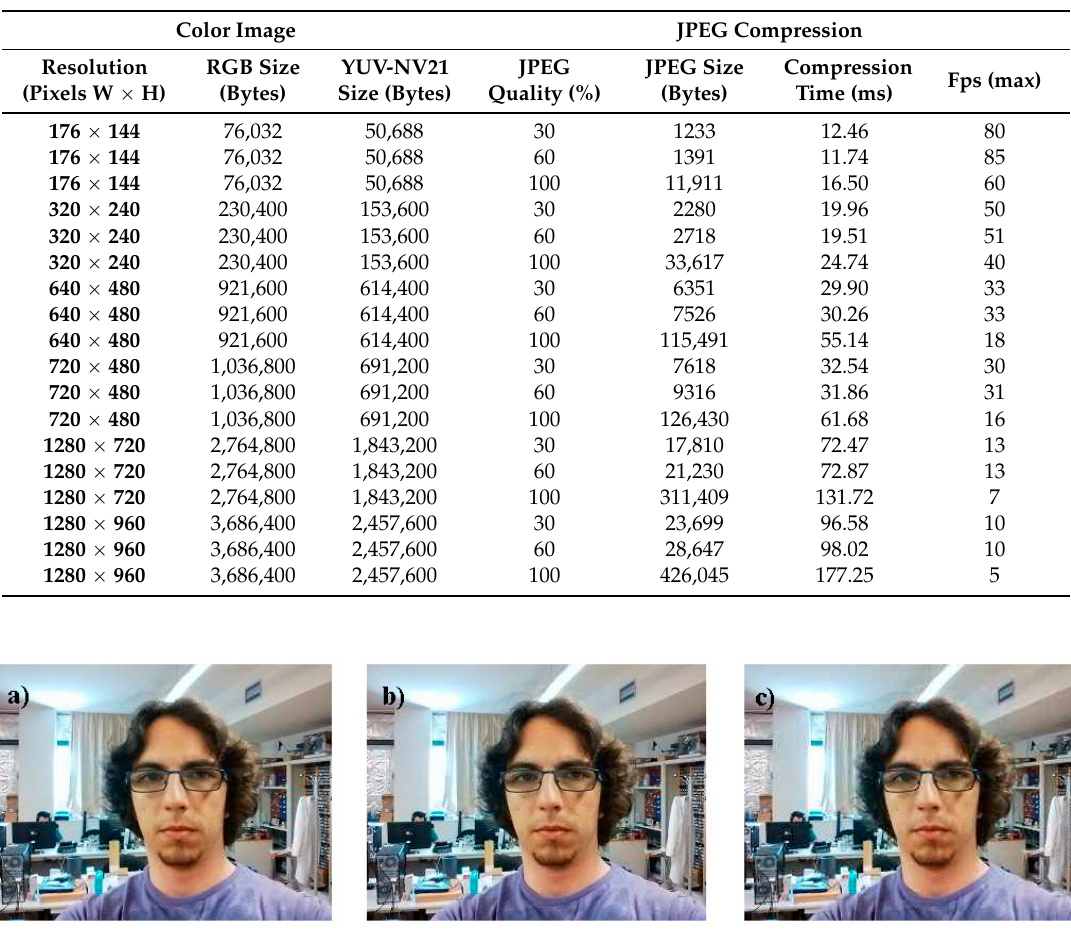
Figure 9. Sample 320 × 240 color image showing the small differences obtained after a JPEG compression and decompression procedure with quality settings of ( a ) 100%; ( b ) 60%; ( c ) 30%.